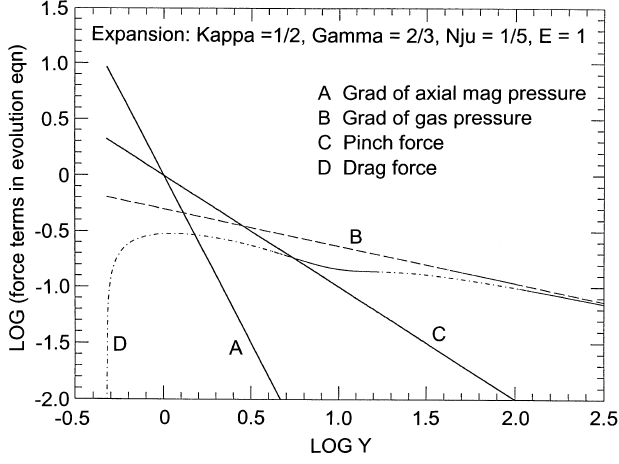
Fig. 2. The forces acting on an expanding flux rope plotted as function of Y on a log-log scale. The parameters chosen are (cid:106) (cid:136) 1 = 2 ; (cid:99) (cid:109) (cid:3) (cid:136) 2 = 3 ; (cid:136) 1 = 5 and E (cid:136) 1 : For further details, see text